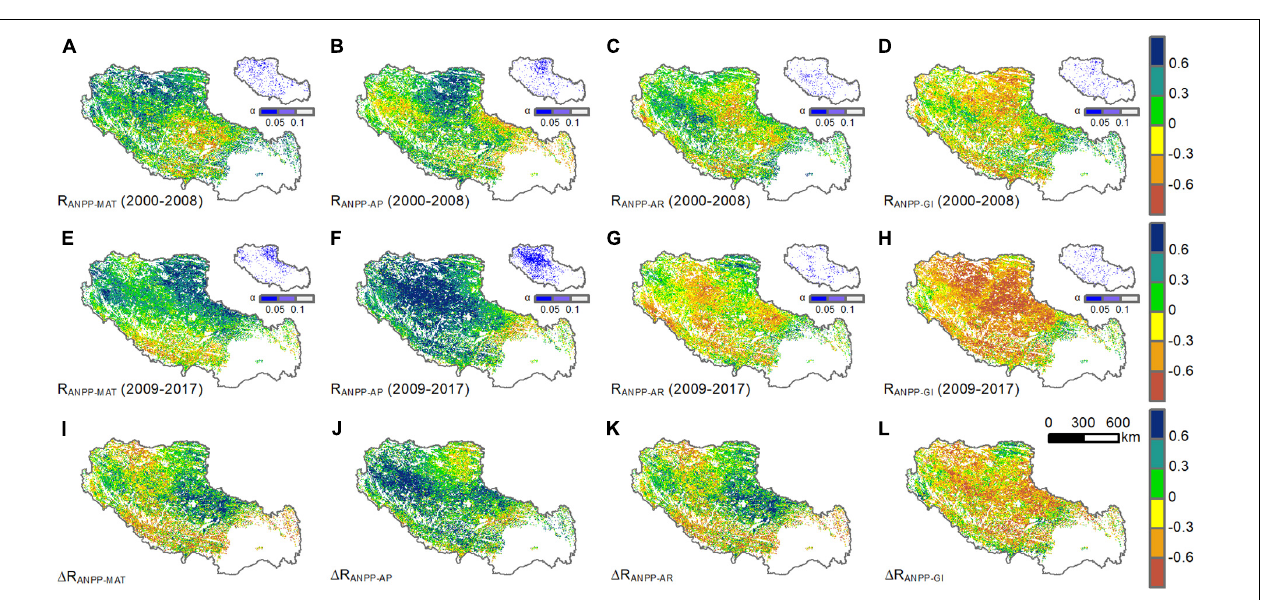
FIGURE 7 | Spatial patterns of the correlation coefficients (R) of grassland ANPP with MAT, AP AR, and GI during (A–D) 2000–2008, (E–H) 2009–2017, and (I–L) the difference in the corresponding correlation coefficients ( (cid:49) R ) between the two subperiods, before and after the starting “ Ecological Security Barrier Protection and Construction Project